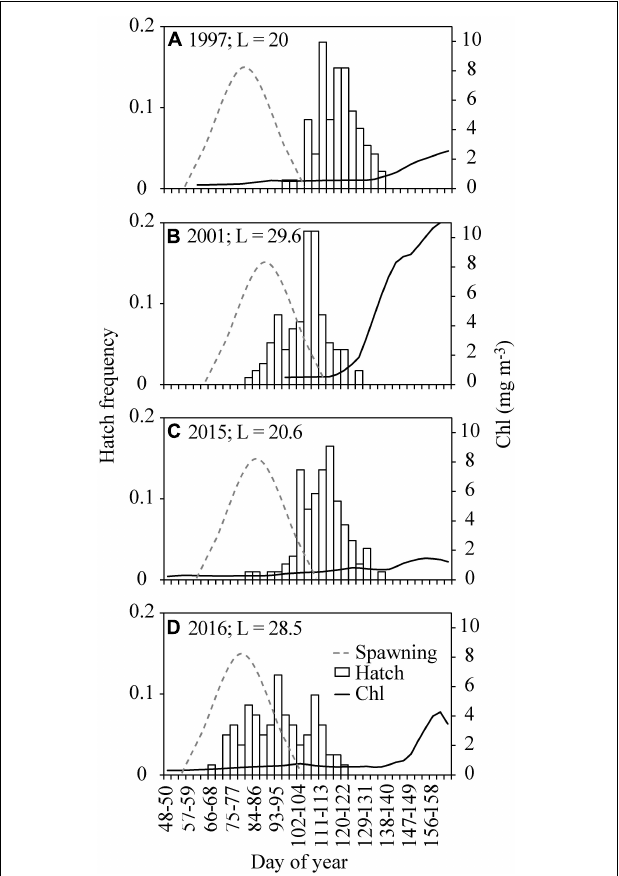
FIGURE 9 | Back-calculated cod hatch day frequency histogram and estimated spawning distribution (dashed line) in (A) 1997, (B) 2001, (C) 2015, and (D) 2016 together with chl at station S (black line) from mid February to mid June (i.e., the beginning of the 0-group survey). The mean length (mm) (L) of the fish included in the otolith analysis is indicated for each year.